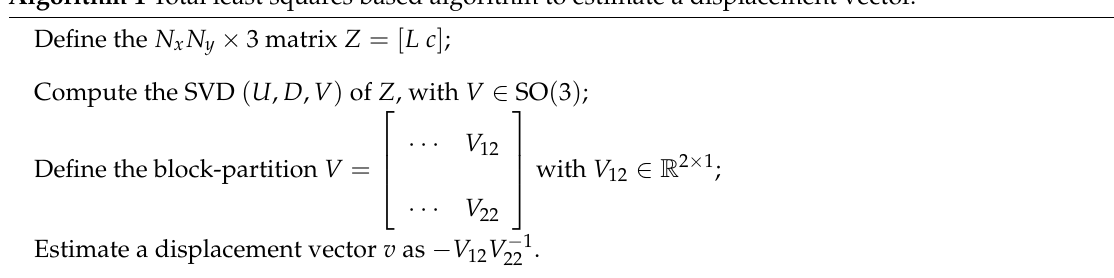
Algorithm 1 Total least squares based algorithm to estimate a displacement